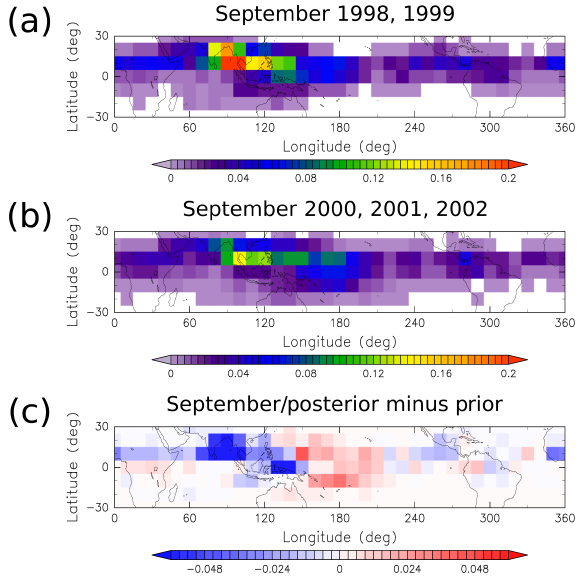
Figure 7. The same as the top three panels of Fig. 6 except that E( LCP ∈ j) , the contribution of bin j to [H 2 O] e , (ppmv) is illus- trated. See text for the definition of E( LCP ∈ j)